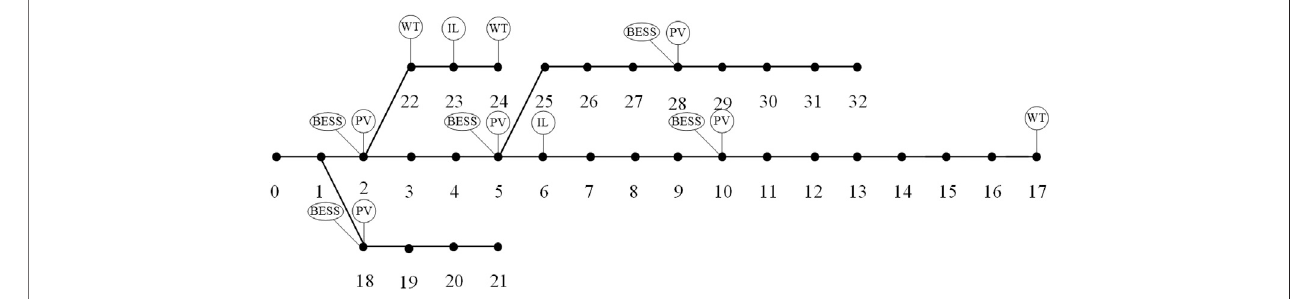
FIGURE 3 | An modi fi ed IEEE 33-node distribution system.